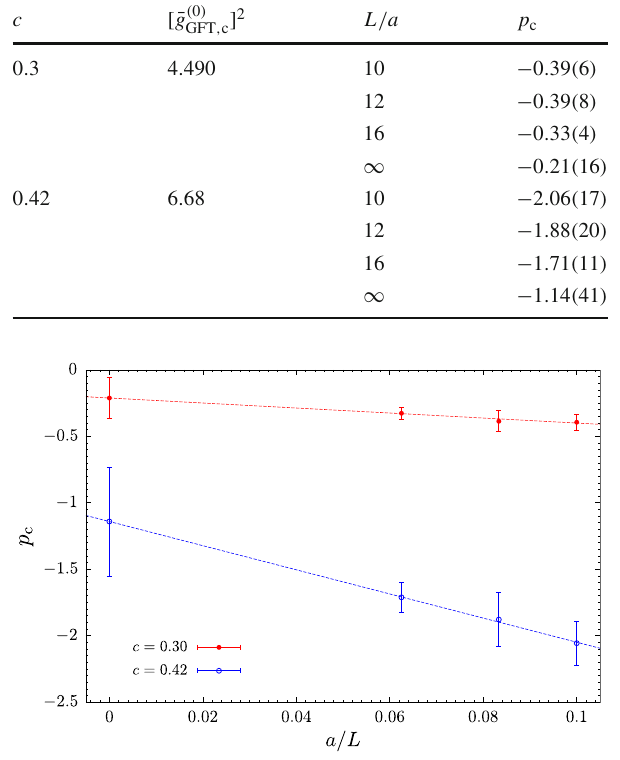
Fig. 5 Illustrative continuum limit extrapolations for the p c results of Table 8